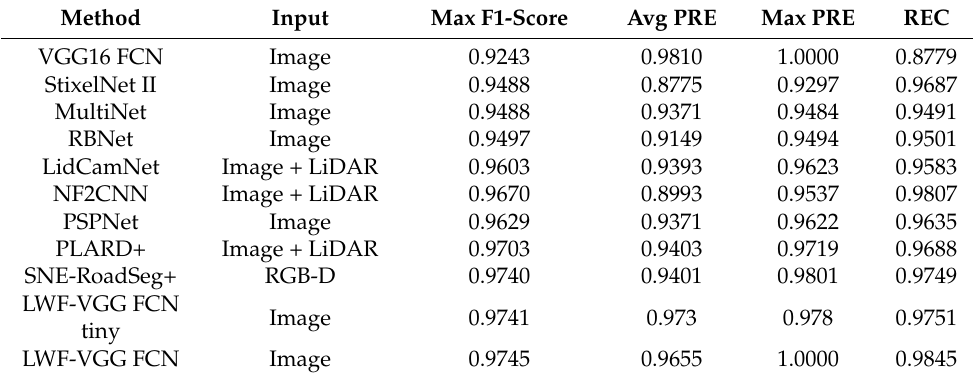
Table 2. Performance of different neural networks using the KITTI road dataset. Max: maximum; Avg: average; PRE: precision; REC: recall.